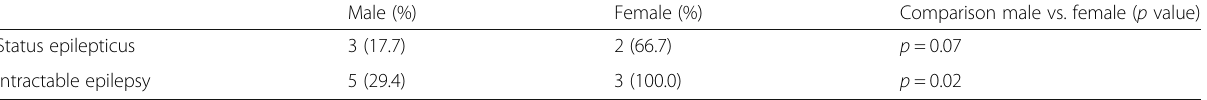
Table 1 Severity of epilepsy amongst autistic children Male (%) Female (%) Comparison male vs. female ( p value) Status